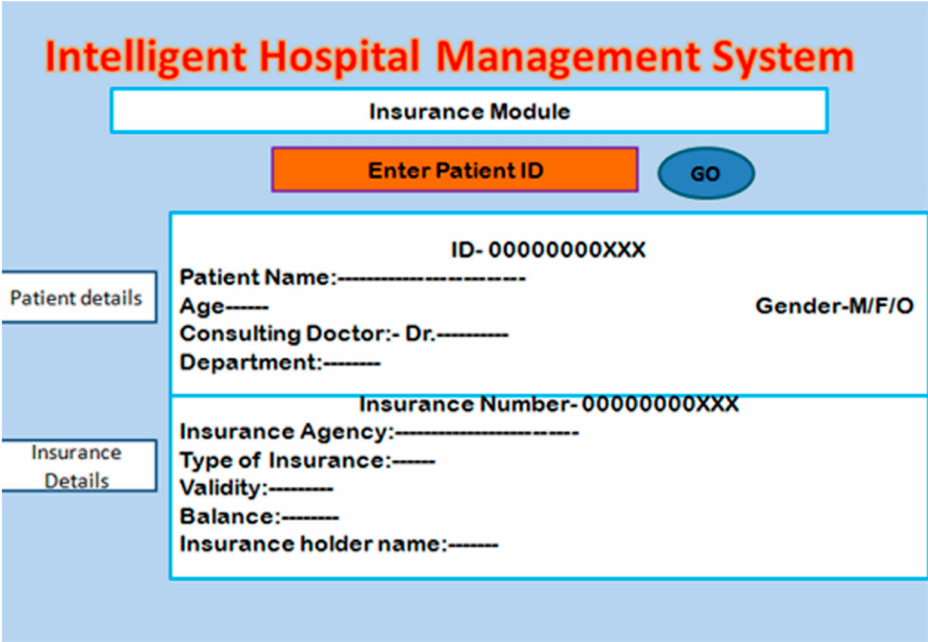
Figure 7. Patient insurance check